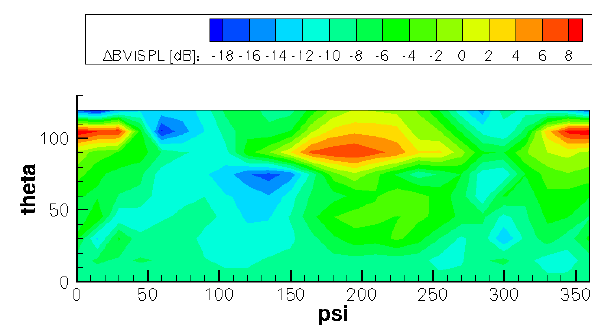
Figure 17: Technique A – B differential BVISPL at point 4 in maneu- ver ID8021.